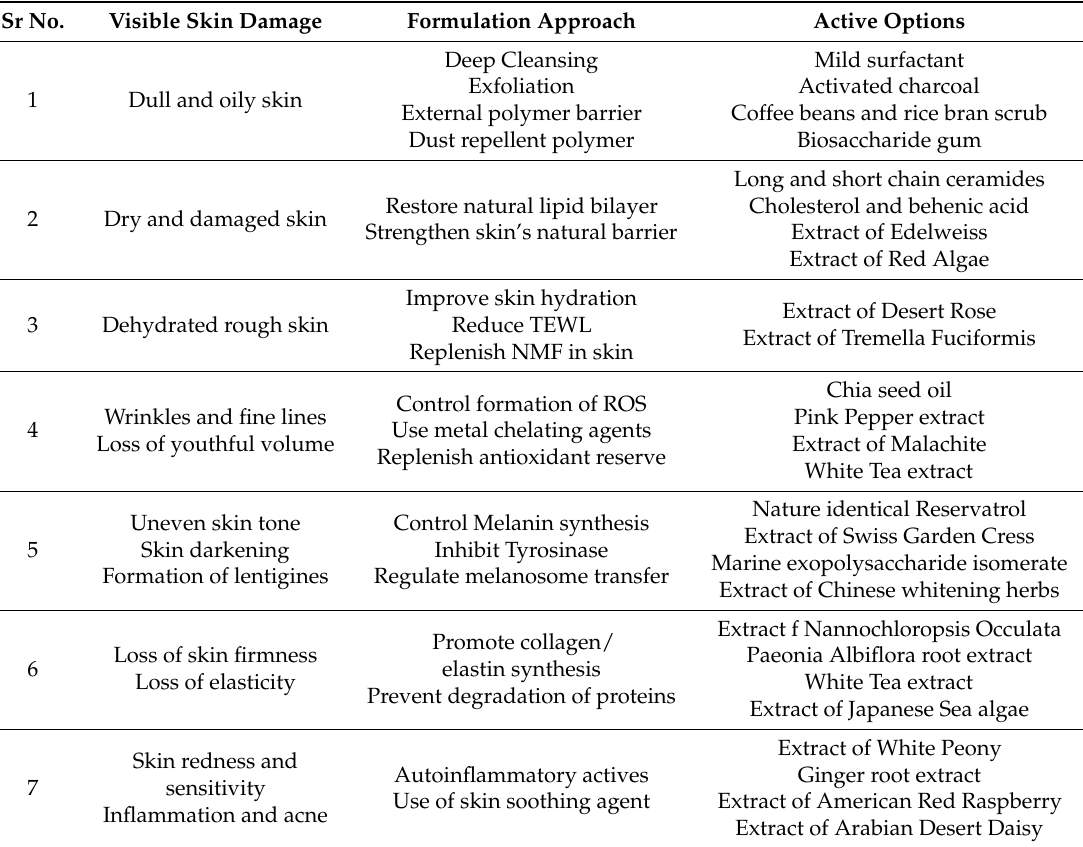
Table 1. Guidelines for formulating anti-pollution